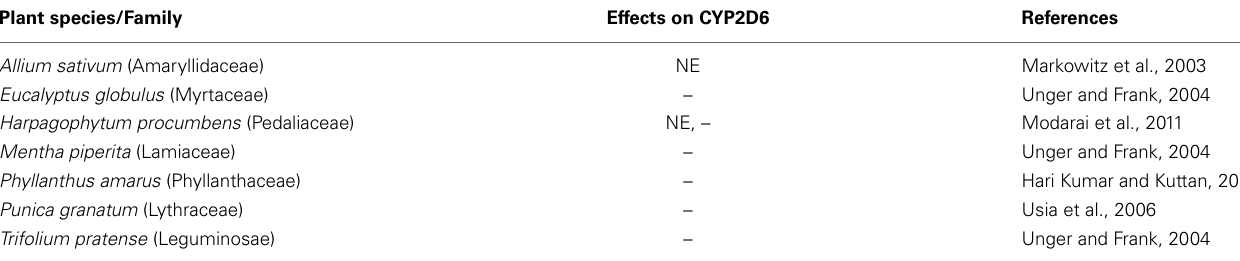
Table 4 | Medicinal plant species listed in RENISUS with reported effects of on CYP2D6. Plant species/Family